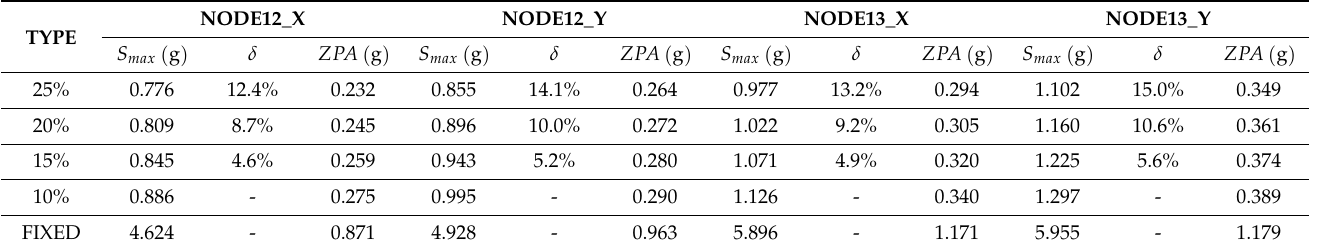
Table 3. Comparison of peak values and ZPA of the FRS in the horizontal